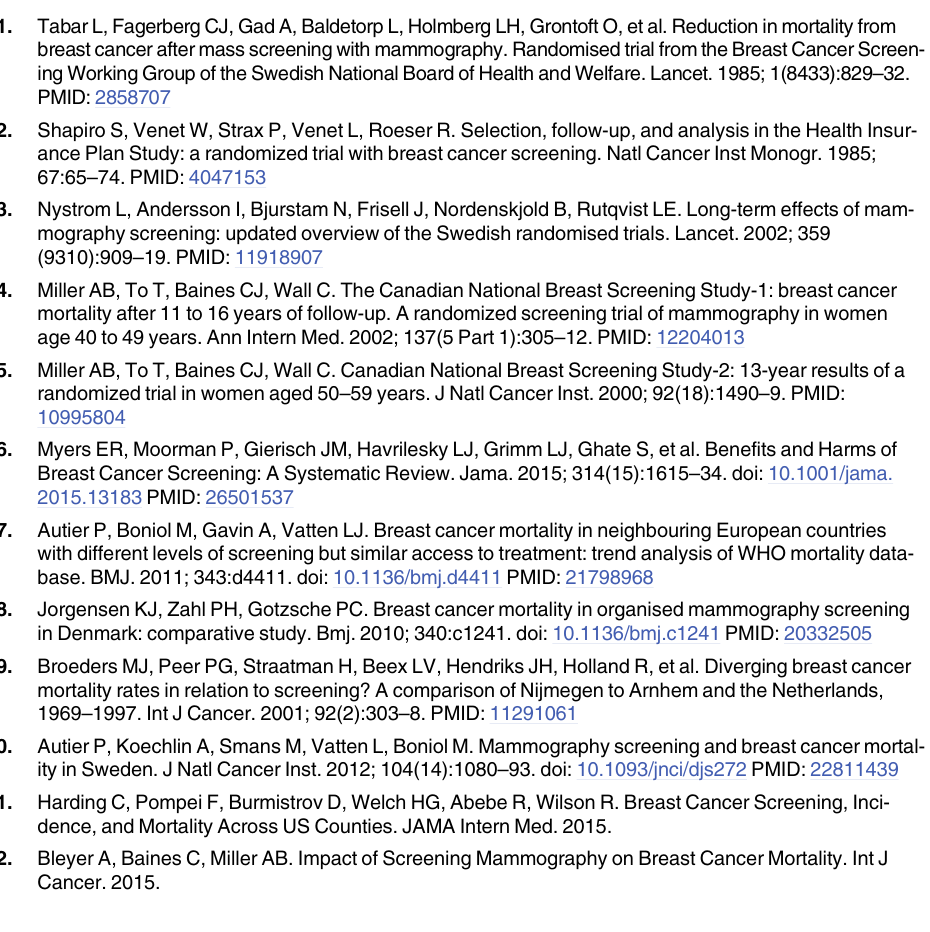
S1 Table. Predicted numbers of breast cancer deaths in the two-County trial reported in Tabar et al, Cancer, 1995, table 6. (cid:1) Data in italicized letters were not reported table 6 of Tabar et al, 1995.[1]. † Includes invasive and in situ cancers. S2 Table. Reported invasive breast cancer patients and deaths in the HIP trial. BC: breast cancer. (cid:1) Data from Table 9 of Shapiro et al, 1977